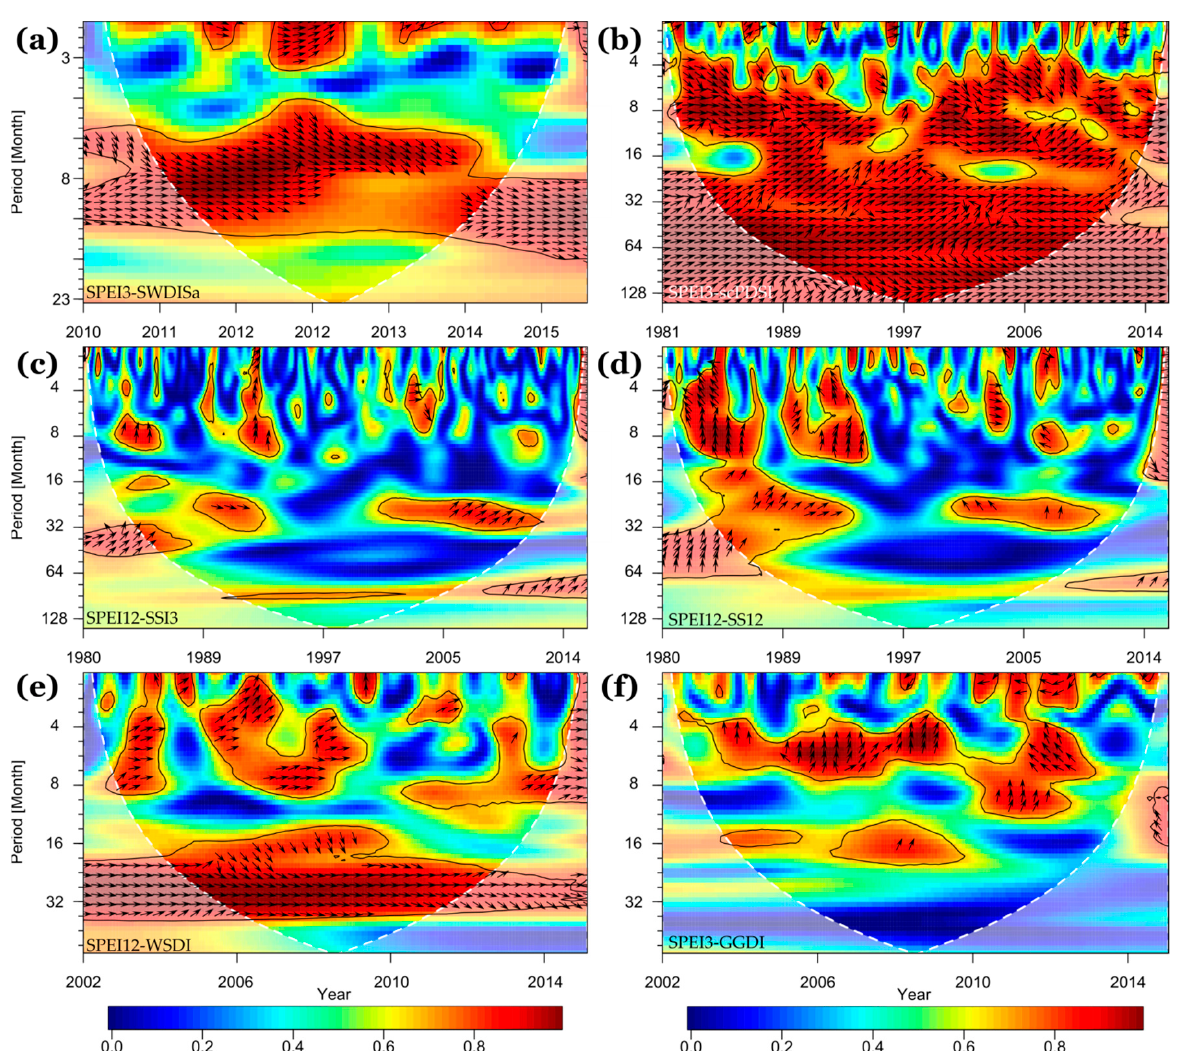
Figure 9. The squared wavelet coherence between the area-averaged values over the entire SFRB of the ( a ) SPEI3 against SWDISa during 2010–2015, ( b ) SPEI3 against scPDSI during 1981–2015, ( c ) SPEI12 against SSI3 during 1980–2015, ( d ) SPEI12 against SS12 during 1980–2015, ( e ) SPEI12 against WSDI during 2002–2015, and ( f ) SPEI3 against GGDI during 2002–2015. Thick contours enclose the areas with correlations statistically significant at 95% confidence level against red noise. Semitransparent areas indicate the ‘cone of influence’ where the edge effects become important; therefore, they were not analyzed. The relative phase relationship is shown as arrows (with in-phase pointing right, anti-phase pointing left, SPEI3 or SPEI12 leading paired variable by 90° pointing straight down, and paired variable leading SPEI3 or SPEI12 by 90 pointing straight up).